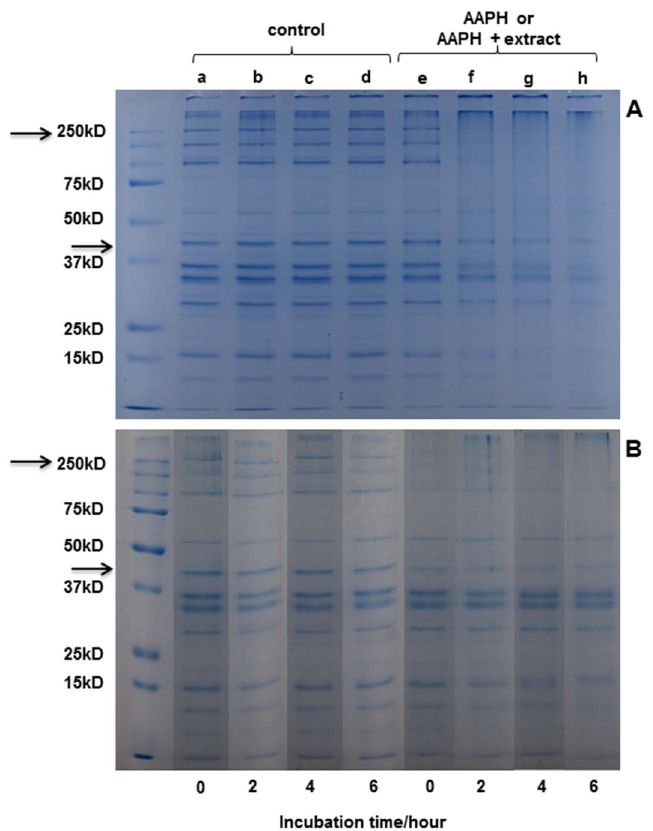
Figure 4. SDS-PAGE analysis of myofibrillar proteins incubated with different systems. ( A ) Buffer (a, b, c, and d) or peroxyl radicals (e, f, g, and h) generated from 10 mM AAPH in 100 mM phosphate buffer, pH 7.4, at 37 °C for 0, 2, 4, or 6 h. ( B ) Buffer (a, b, c, and d) or D. winteri (canelo) plus peroxyl radicals (e, f, g, and h) generated from 10 mM AAPH in 100 mM phosphate buffer, pH 7.4, at 37 °C for 0, 2, 4, or 6 h. (MW 250 kD corresponding to myosin; MW 47 kD corresponding to actine).